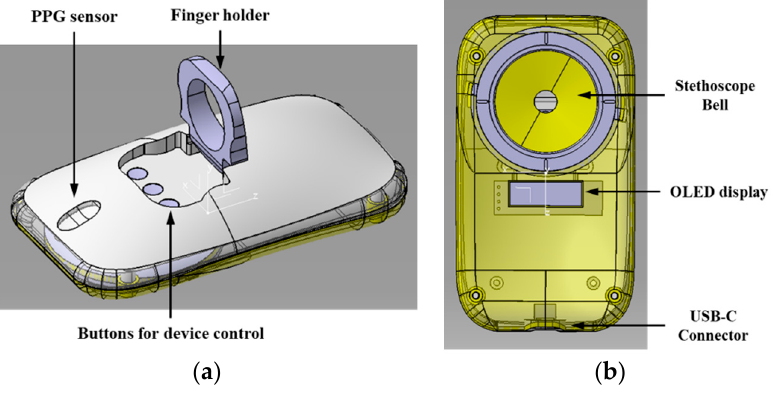
Figure 1. Design of the shape of proposed smart stethoscope: ( a ) top of the device and ( b ) bottom of the device.